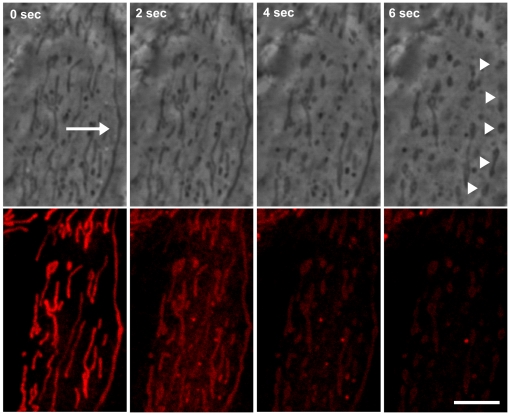
Fragmentation of mitochondria after PDT with compound 5.Top panel: phase contrast, bottom panel: fluorescence of MitoTracker Red CM-H2XRos. Time after LI is shown in upper left corners. Arrow, intact mitochondria; arrowheads, fragmented mitochondria. Bar, 5 µm.